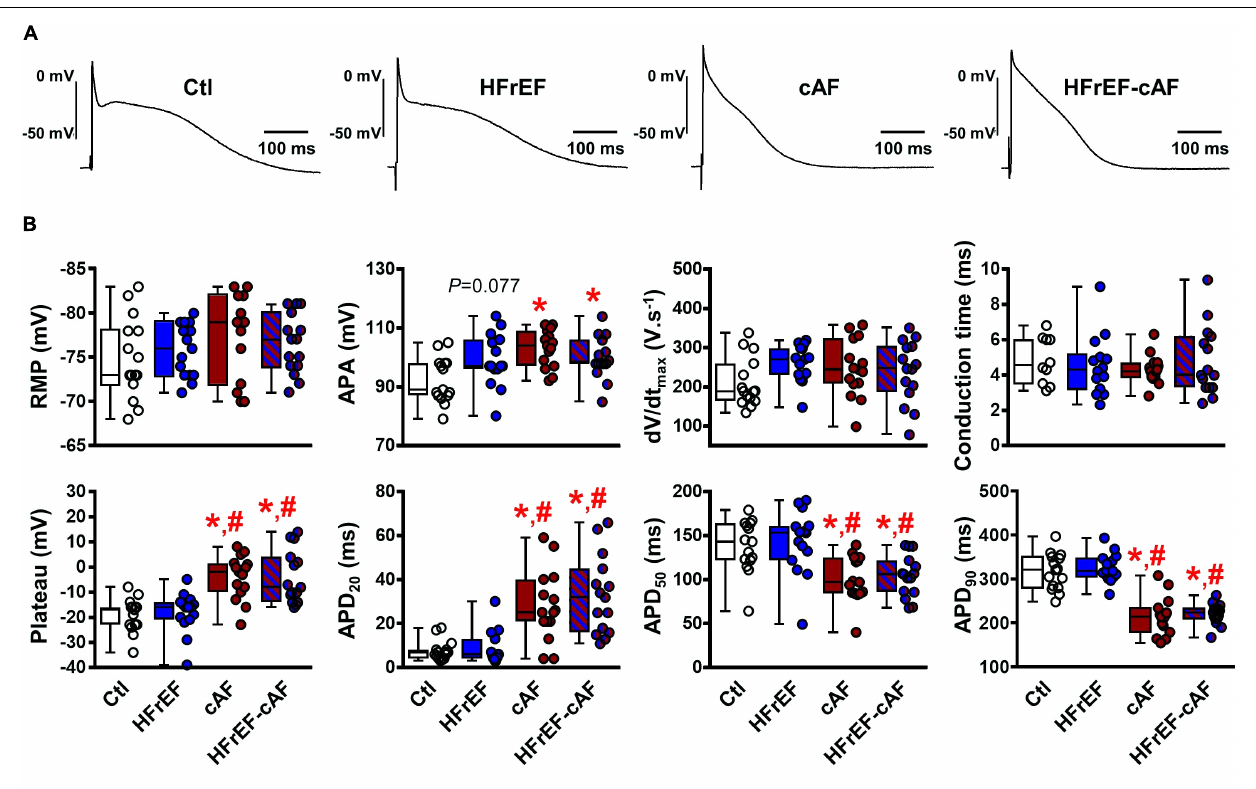
FIGURE 2 | Electrical remodeling in multicellular human atrial trabeculae. (A) Representative action potential (AP) recordings in multicellular preparations from Ctl, HFrEF, cAF or HFrEF-cAF patients (from left to right). (B) Quantification of AP parameters in Ctl (white bars), HFrEF (blue bars), cAF (red bars) or HFrEF-cAF (red/blue-striped bars) patients. Top row shows (from left to right): resting membrane potential (RMP), AP amplitude (APA), maximal AP upstroke velocity (dV/dt max ) and conduction time (note different n-numbers). Bottom row shows (from left to right): level of AP plateau and AP duration (APD) at 20%, 50%, and 90% of repolarization. ∗ indicates P < 0.05 vs. Ctl, # indicates P < 0.05 vs. HFrEF. Numbers indicate number of